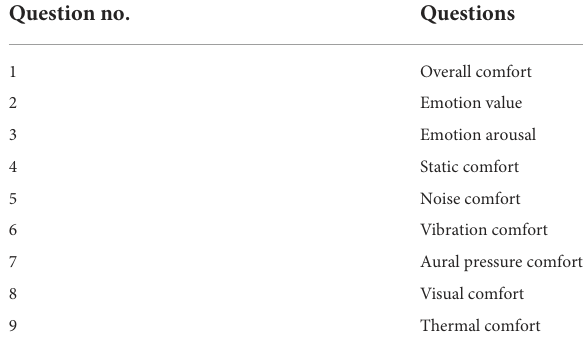
TABLE 1 Subjective